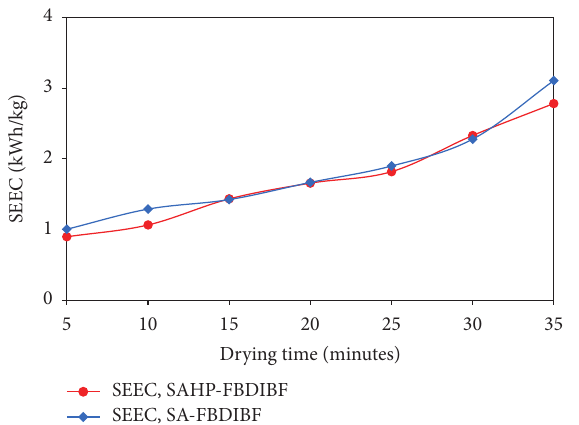
Figure 22: The variation of thermal efficiency with drying time.